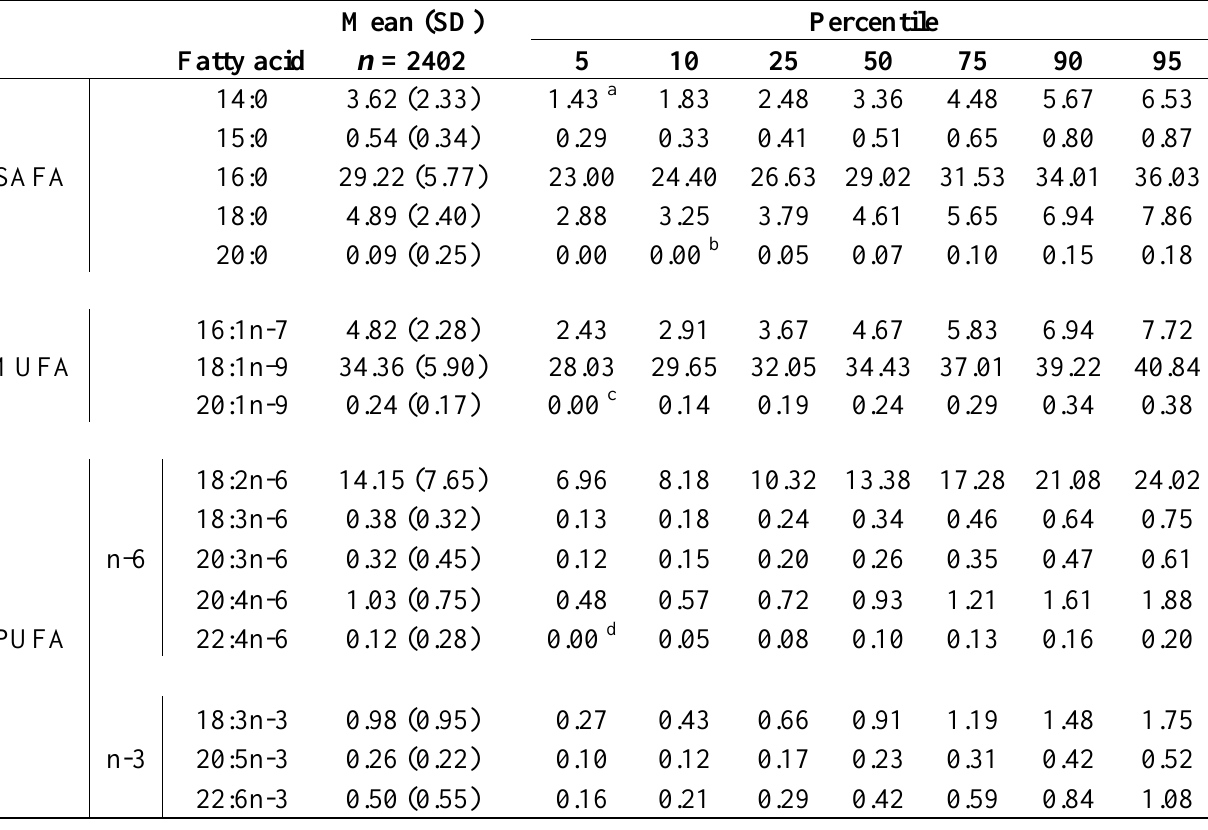
Table 5. National Nutrition Survey participant percentiles for serum triacylglycerol fatty acid